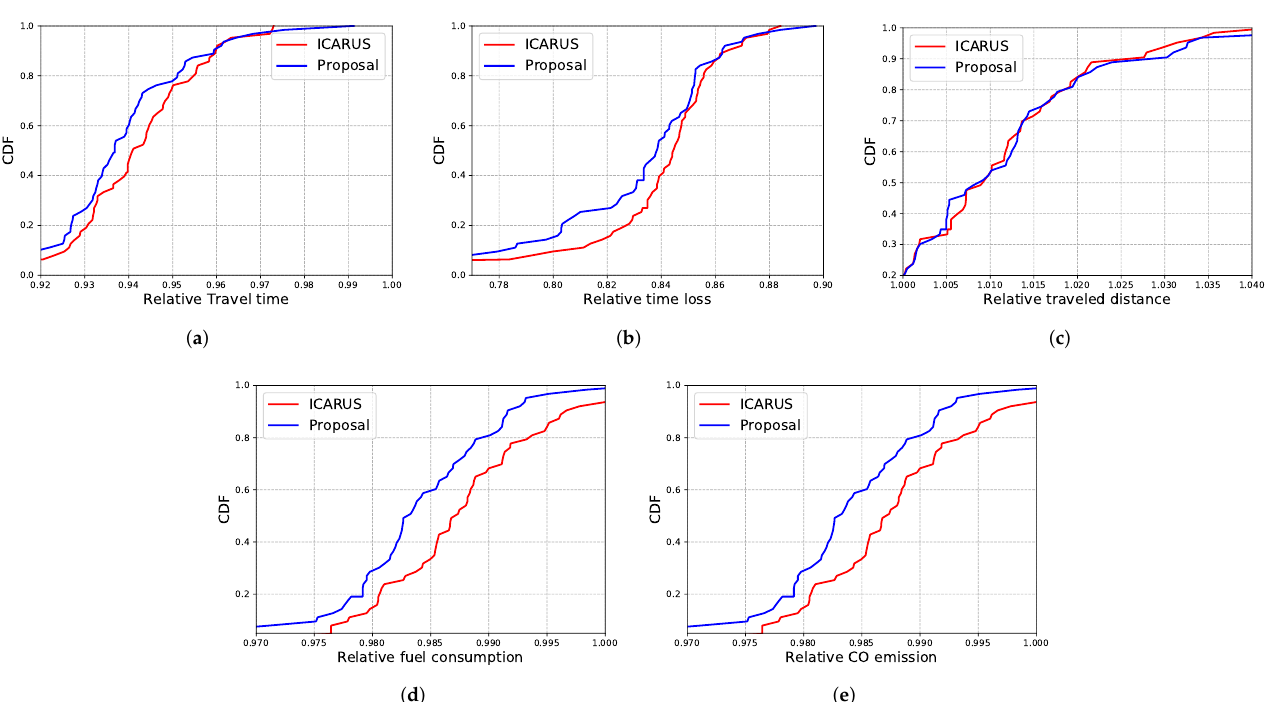
Figure 11. Traffic efficiency results. ( a ) Travel time; ( b ) Time loss; ( c ) Traveled distance; ( d ) Fuel consumption; ( e ) CO